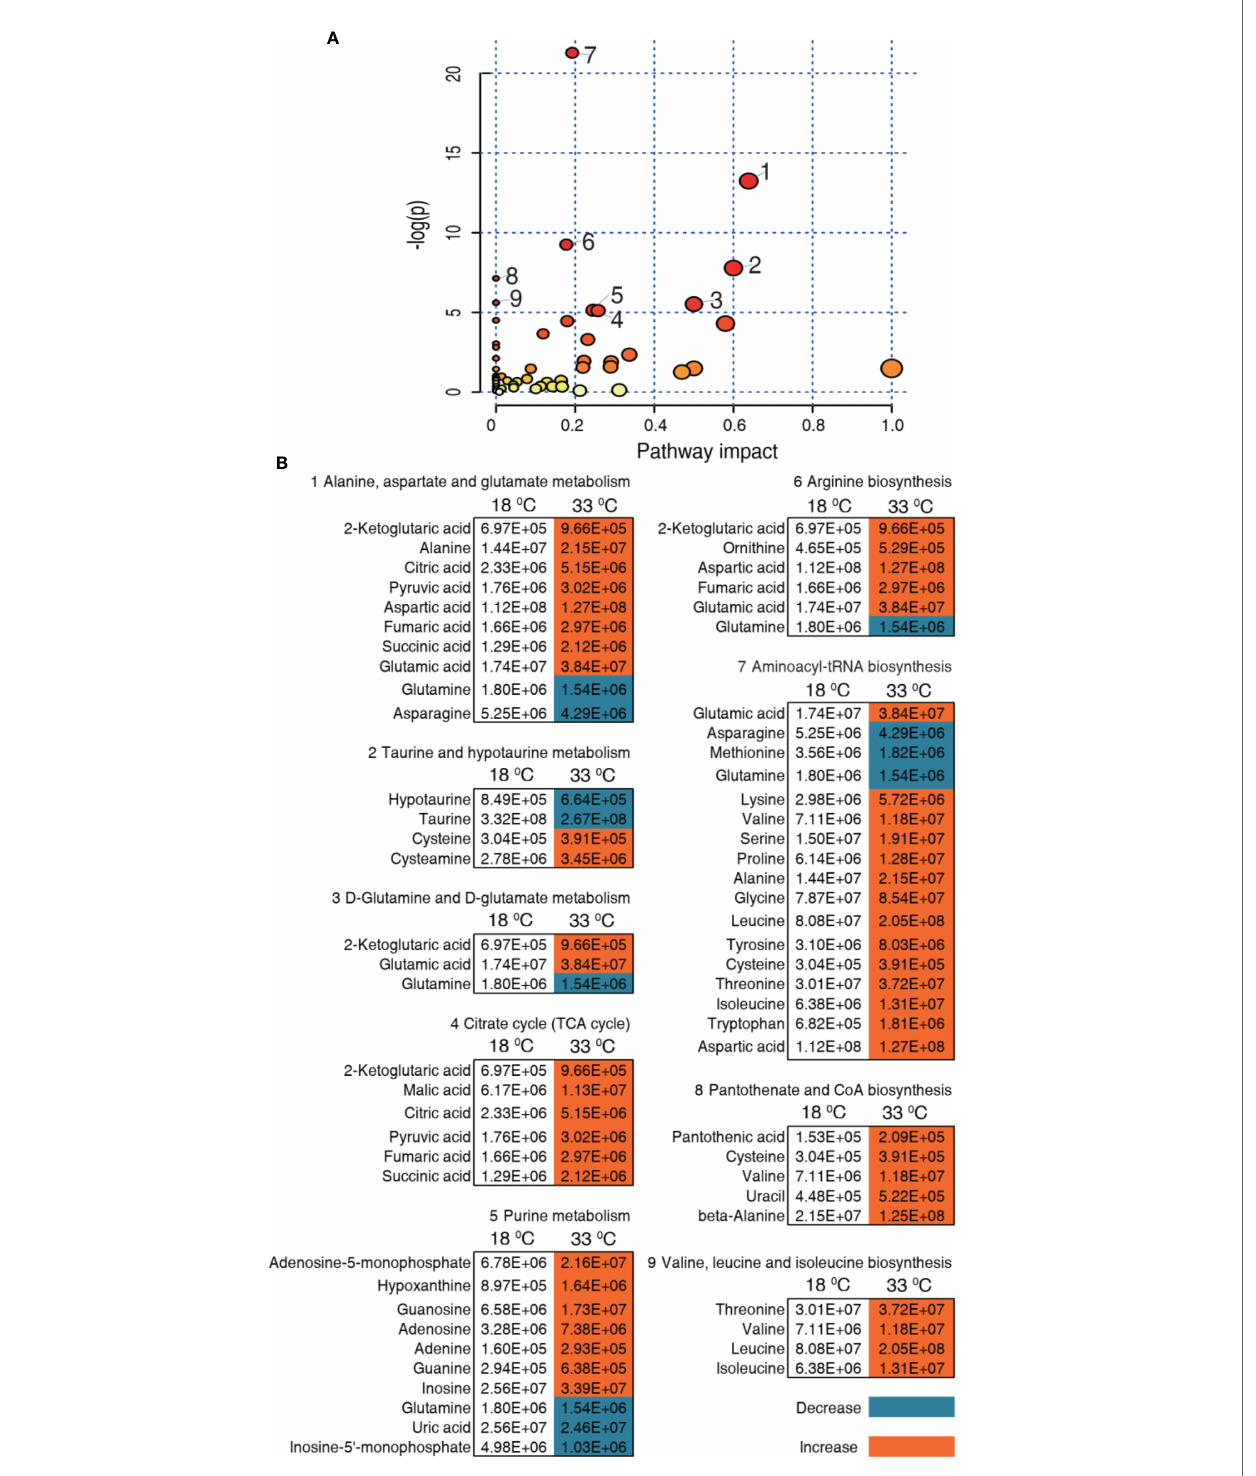
FIGURE 5 | Pathway enrichment and analysis. (A) Pathway enrichment of differential metabolites in the 33°C group compared with the 18°C group. In terms of impact value from the largest to the smallest, 1 to 9, respectively, represent alanine, aspartate and glutamate metabolism; taurine and hypotaurine metabolism; D-glutamine and D-glutamate metabolism; citrate cycle (TCA cycle); purine metabolism; arginine biosynthesis; aminoacyl-tRNA biosynthesis; pantothenate and CoA biosynthesis; and valine, leucine, and isoleucine biosynthesis. Signi fi cantly enriched pathways are selected to plot. (B) Integrative analysis of metabolites in signi fi cantly enriched pathways. Red and blue indicate increased and decreased metabolites,